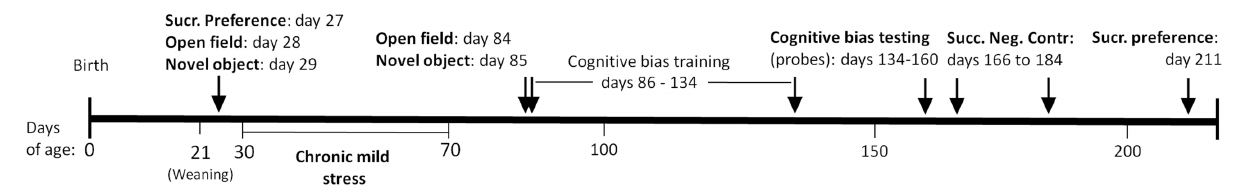
FIGURE 1 | Timeline of procedures. We evaluated the long-term effects of chronic unpredictable stress during the adolescent life stage on adult cognition and behavior using the following tests: cognitive bias, successive negative contrast, sucrose preference, novel object, and open field.